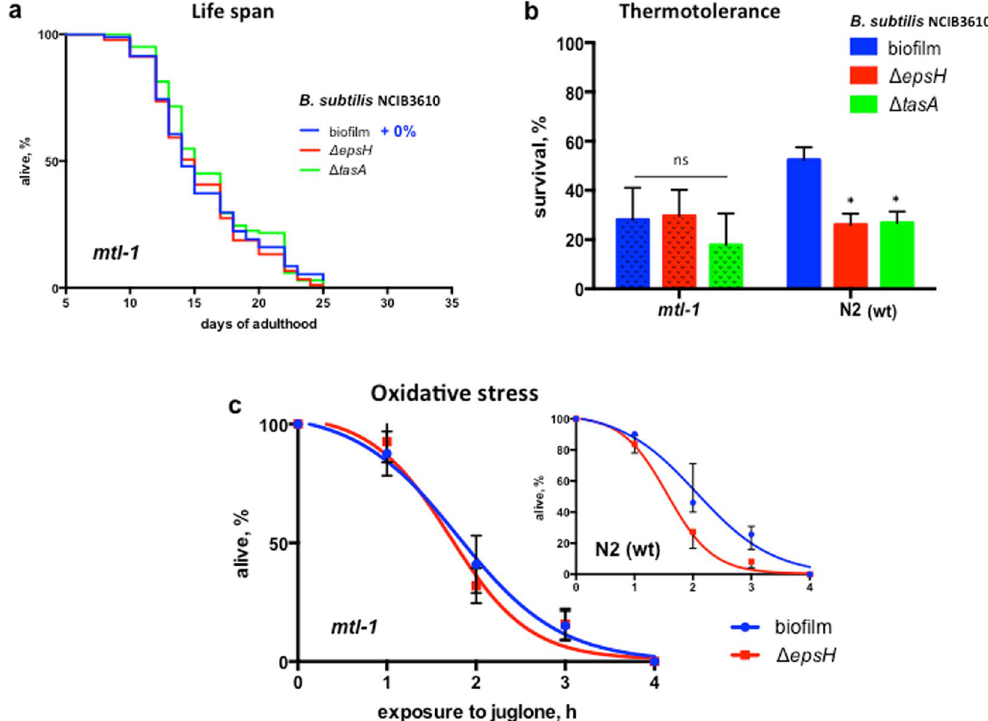
Figure 4. Biofilm acts via induction of metallothionein in C. elegans . In each case the average values ± SD from at least three independent experiments are plotted. Each experiment includes at least 60 worms per condition. ( a ) MTL-1 is required for biofilm-dependent lifespan extension. C. elegans mtl-1 (tm1770) were fed either biofilm-forming B. subtilis (biofilm, blue) or its biofilm-deficient derivatives ( Δ epsH and Δ tasA , red and green, respectively). The graph is representative of three independent biological replicates. Median lifespan, days: biofilm–15; Δ epsH –15; Δ tasA –15. The log-rank test p-value for each experiment is > 0.05, Supplementary Table S3. ( b ) MTL-1 is required for biofilm-mediated thermotolerance. Wild-type (N2) and mtl-1 (tm1770) C. elegans were grown in parallel on indicated bacterial strains until day 5 of adulthood and then subjected to heat shock at 33 °C for 3 hours. Surviving animals were scored after 20 hours of recovery at 20 °C. The graph represents mean values ± SD from free independent biological replicates. One-way ANOVA p -value = 0.4800. ( c) MTL-1 is required for biofilm-mediated resistance to oxidative stress. Five-day old wild-type (N2) and mtl-1 (tm1770) C. elegans were grown on indicated bacterial strains, transferred to plates supplemented with juglone (90 μ M) and scored for survival every hour. The graph represents mean values ± SD from free independent biological replicates. Also see Supplemental Table